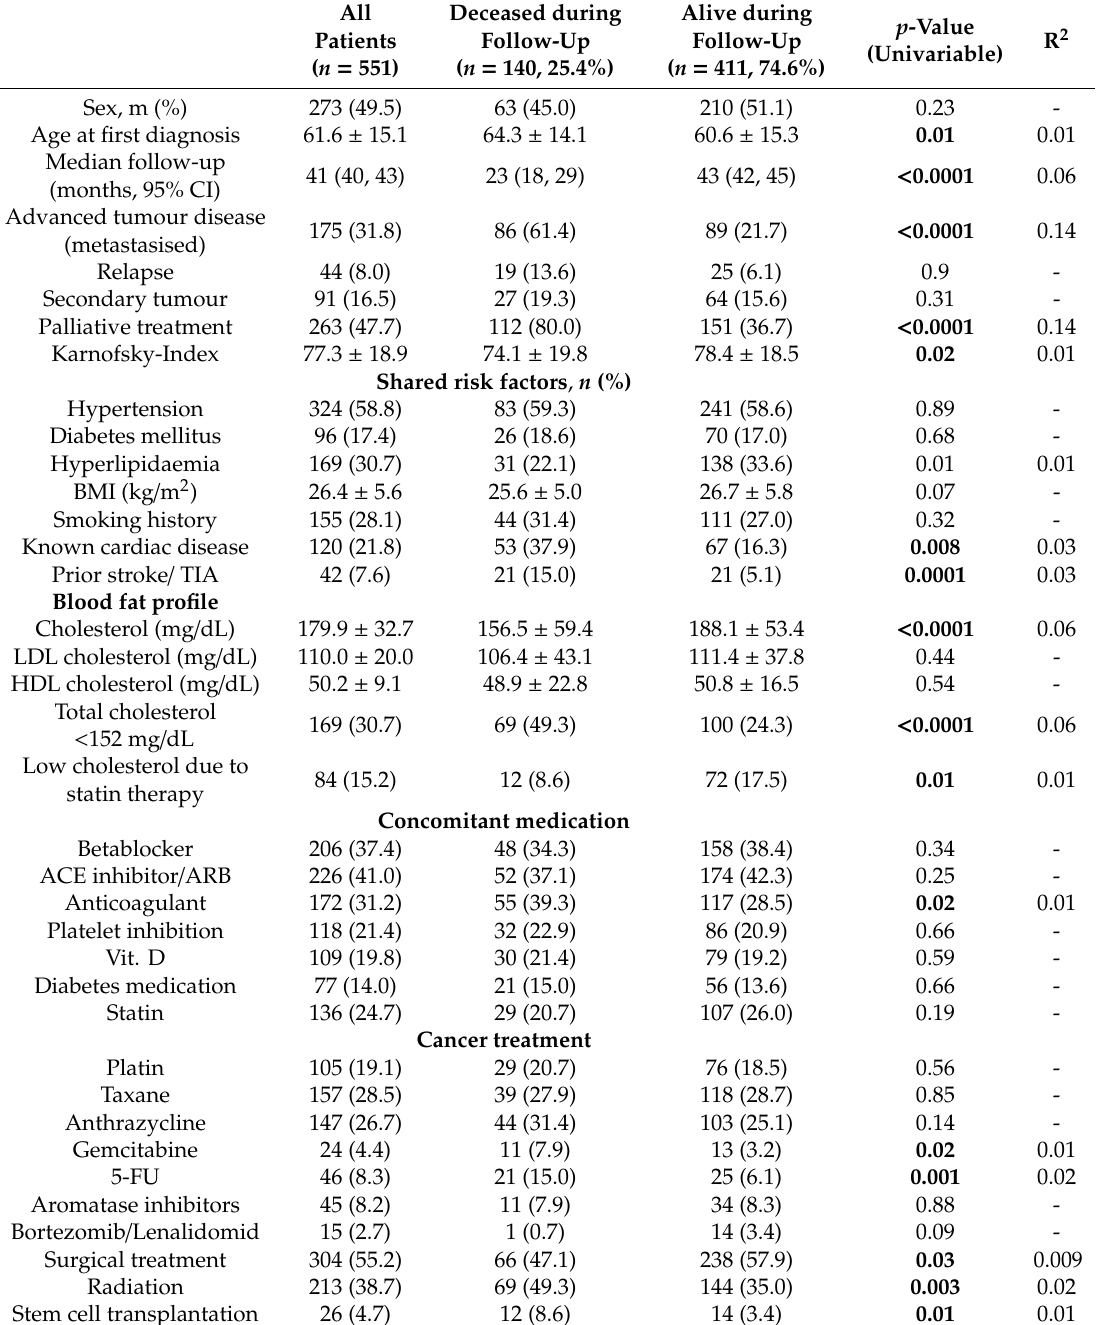
Table 1. Baseline characteristics, risk factors and medical